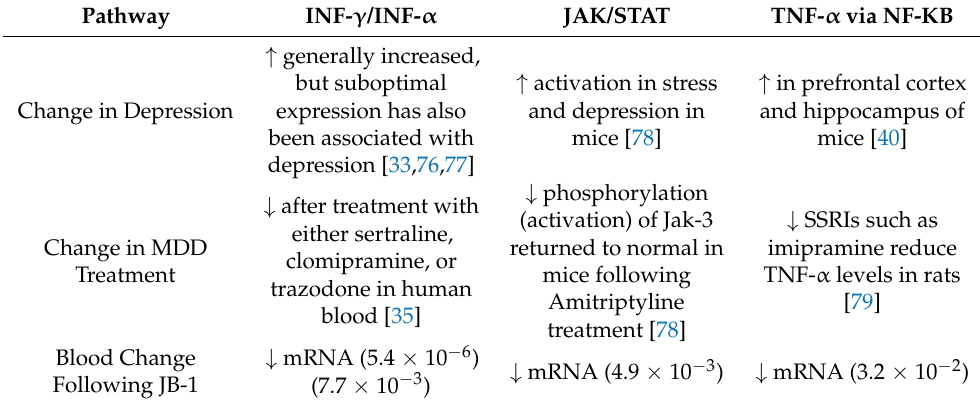
Table 2. Differential expression of pathways relevant to depression, in depression, after established antidepressant treatment, and following JB-1 treatment in mice. The up and down arrows represent the direction of change in pathway expression in our findings and in